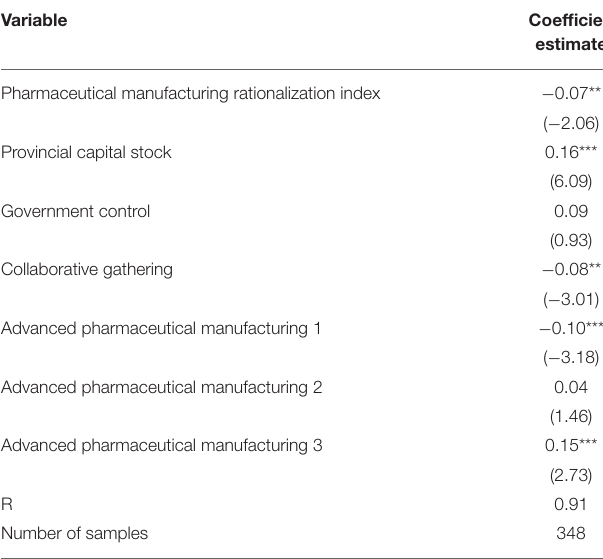
TABLE 9 | Threshold correlation